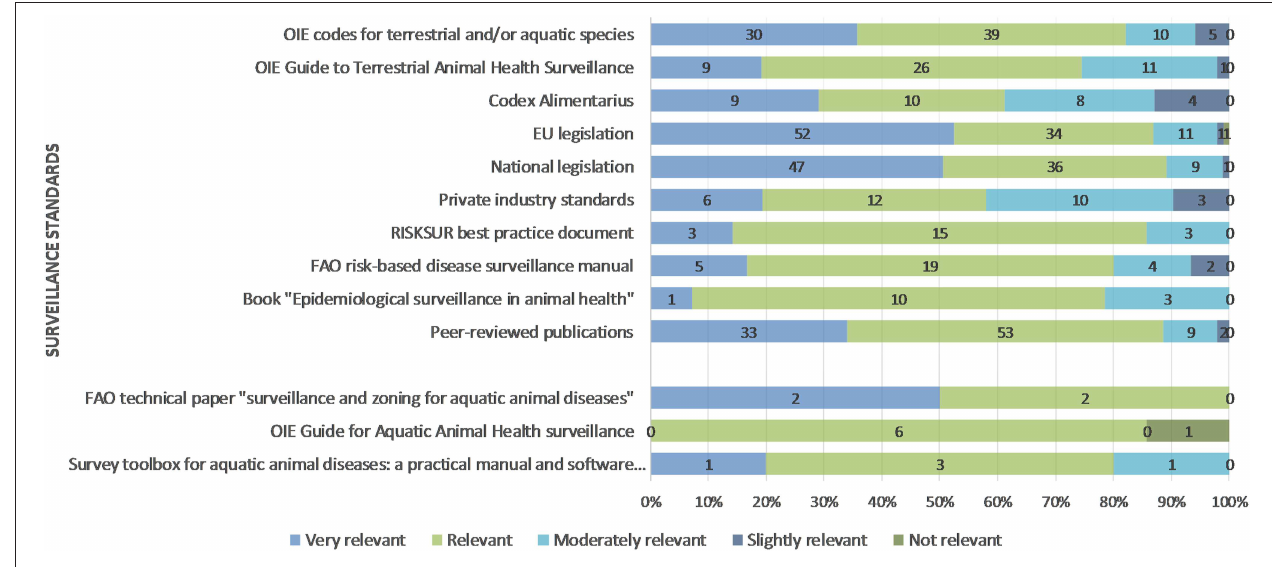
FIGURE 3 | Relevance of standards for the respondents’ surveillance